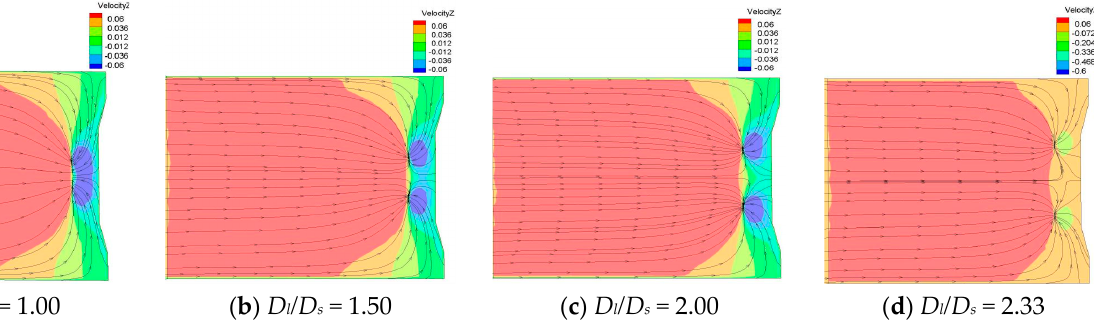
Figure 18. Suction sump axial flow velocity and flow line diagram (section 2 - 1, m/s).